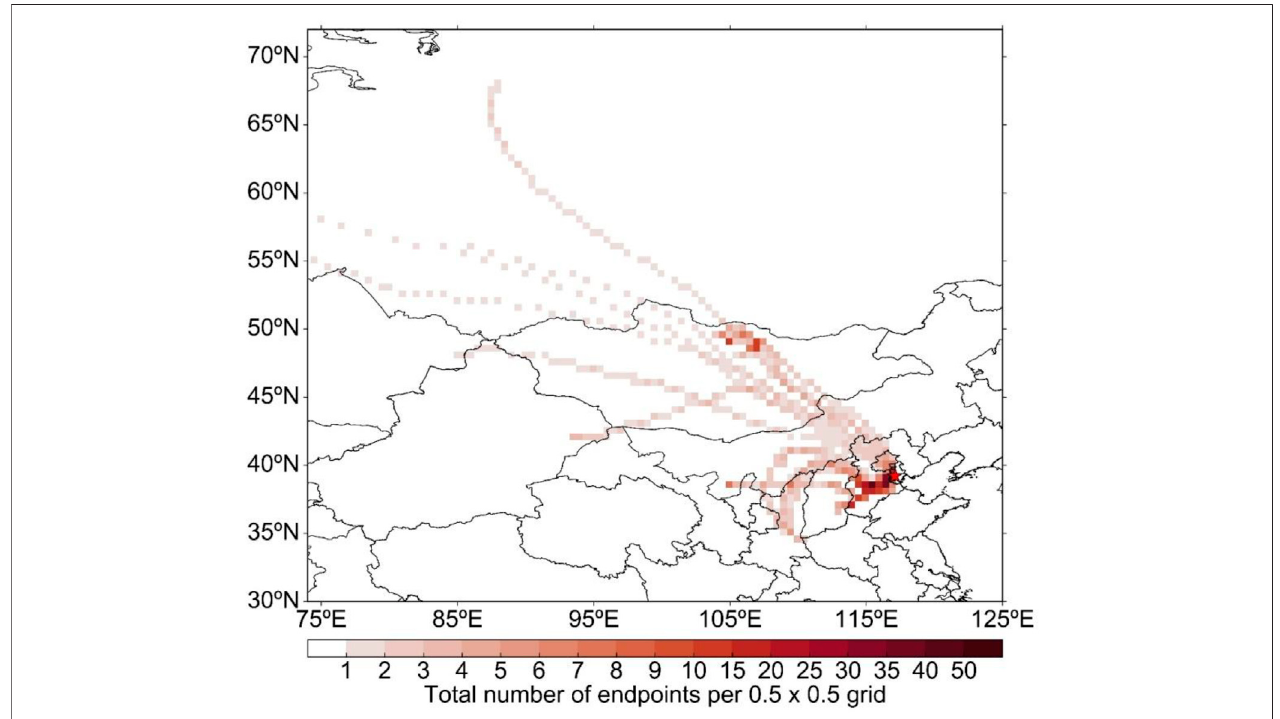
FIGURE 6 | Back trajectories for a 72-h period from 10 to 15 January 2019 in Tianjin, expressed as the total number of trajectory endpoints in each 0.5 × 0.5 grid box.